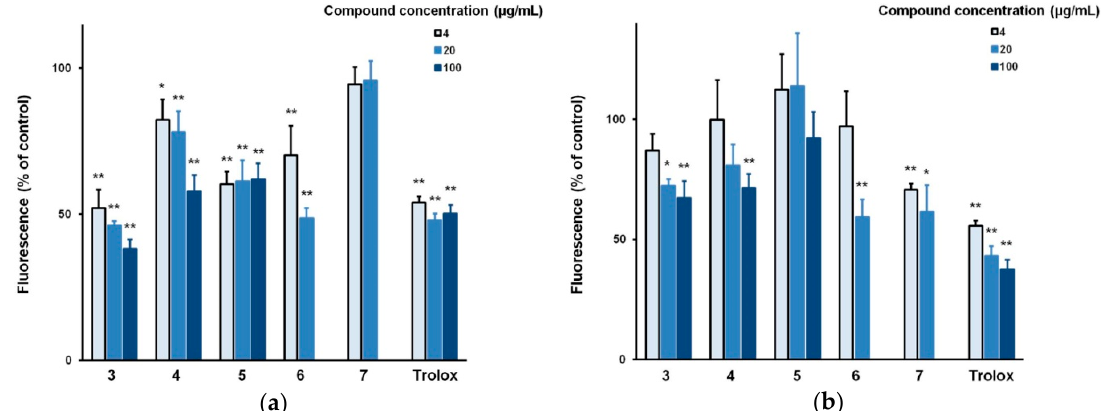
Figure 4. Intracellular antioxidant activity of the isolated compounds. The ability of the isolated compounds to attenuate basal ( a ) or hydrogen-peroxide-stimulated ( b ) (ROS) in human skin fibroblasts was evaluated using DCFH-DA, as described in the Materials and Methods. Vehicle (DMSO) was used as negative control and Trolox as positive one. Results are expressed as percentages of the value of the respective control concentration, and they represent the mean of three independent experiments performed in quadruplicate (* 0.01 < p ≤ 0.05; ** p ≤ 0.01).